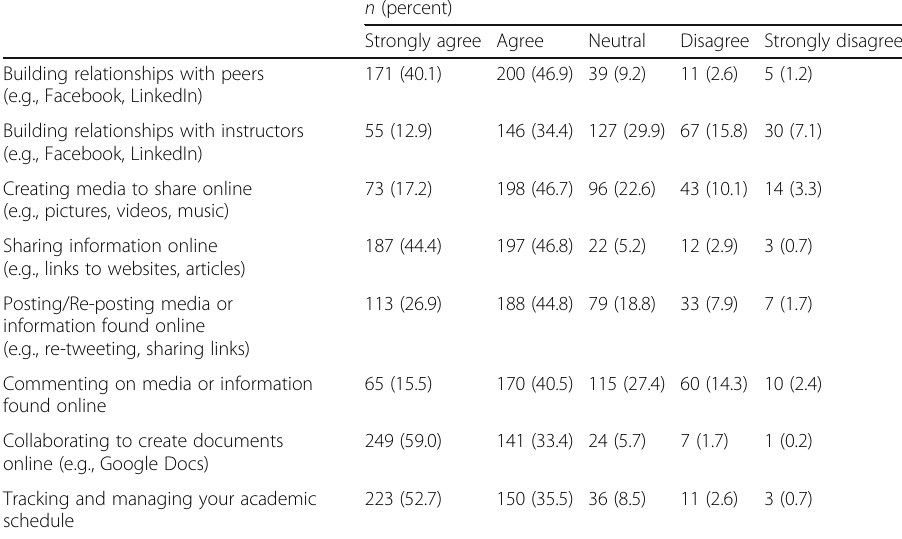
n (percent) Strongly agree Agree Neutral Disagree Strongly disagree 171 (40.1) 200 (46.9) 39 (9.2) 11 (2.6) 5 (1.2) 55 (12.9)